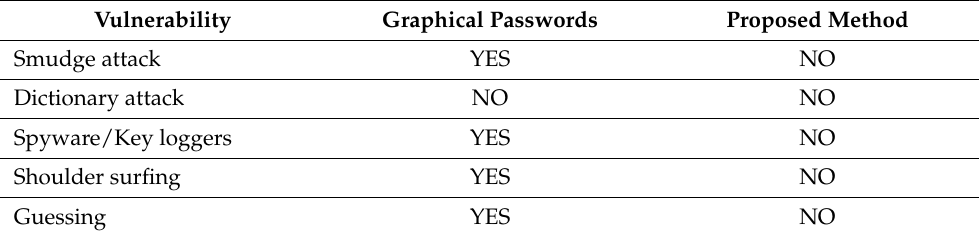
Table 3. Common attacks which other graphical passwords are vulnerable to compared to the proposed method. Vulnerability Graphical Passwords Proposed